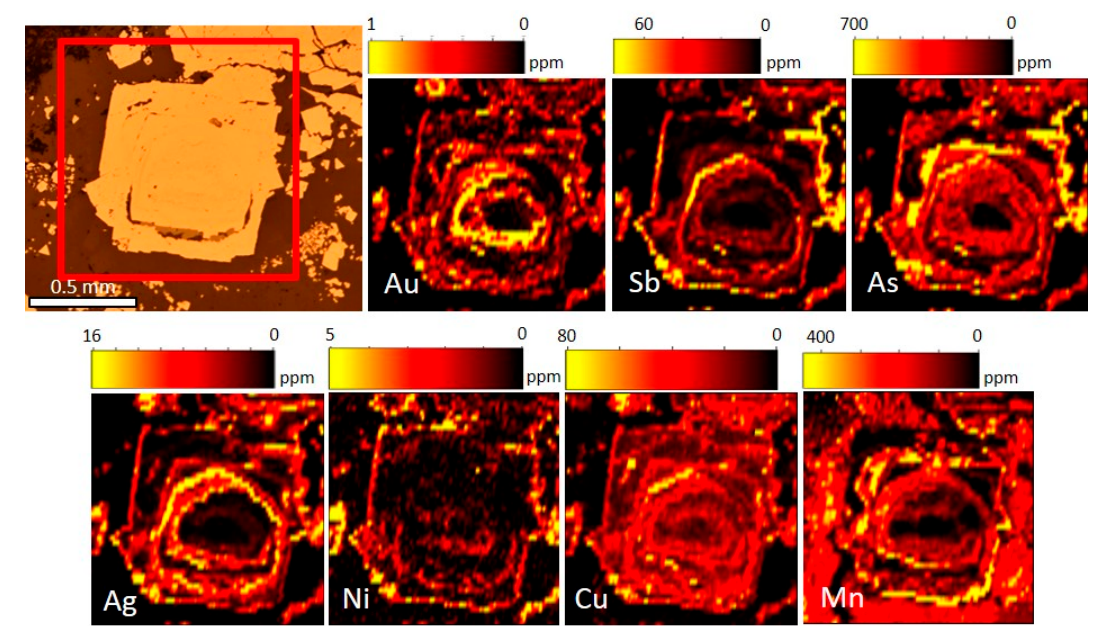
Figure 9. Au, Ag, As, Sb, Ni, Cu and Mn distribution maps of a euhedral pyrite crystal (Py IIb) from sample SR-208/5.5–5.8. The maps show semi-quantitative values.